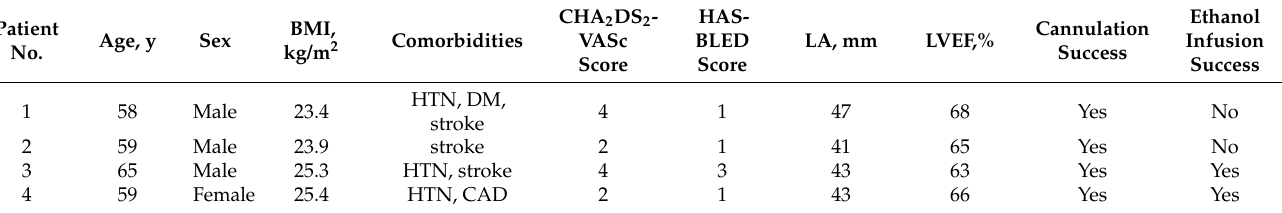
Table 1. Patient characteristics and procedural